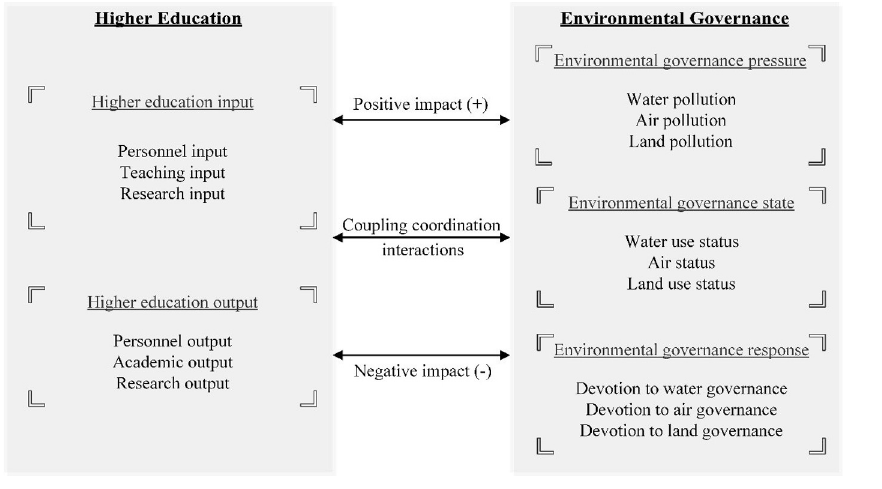
Fig 2. Coupling coordination